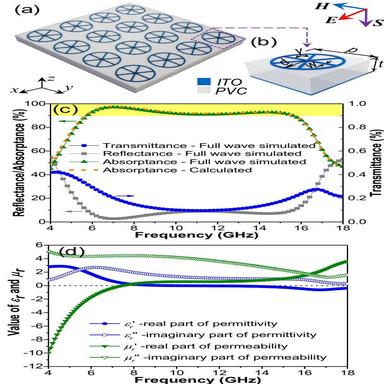
The (a) 4 × 4 structure and (b) magnified "wheel-like" element of designed WMA. (c) The microwave performance of the designed WMA material under normal incident TM plane waves. (d) Frequency-dependent spectra of retrieved effective electromagnetic parameters, complex permittivity εr = εr′ + jεr″ and permeability μr = μr′ + jμ″.